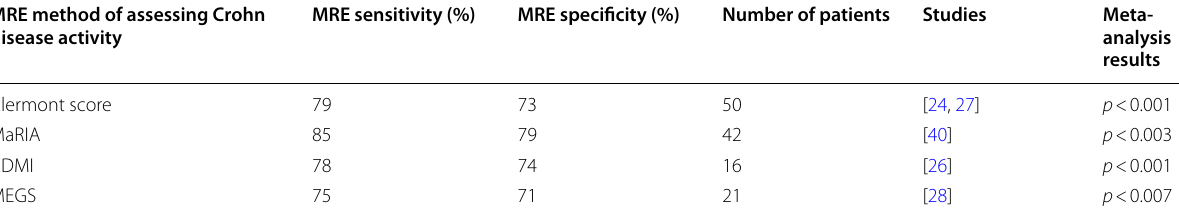
MaRIA Magnetic resonance index of activity, CDMI Crohn Disease MRI Index, MEGS Magnetoencephalography